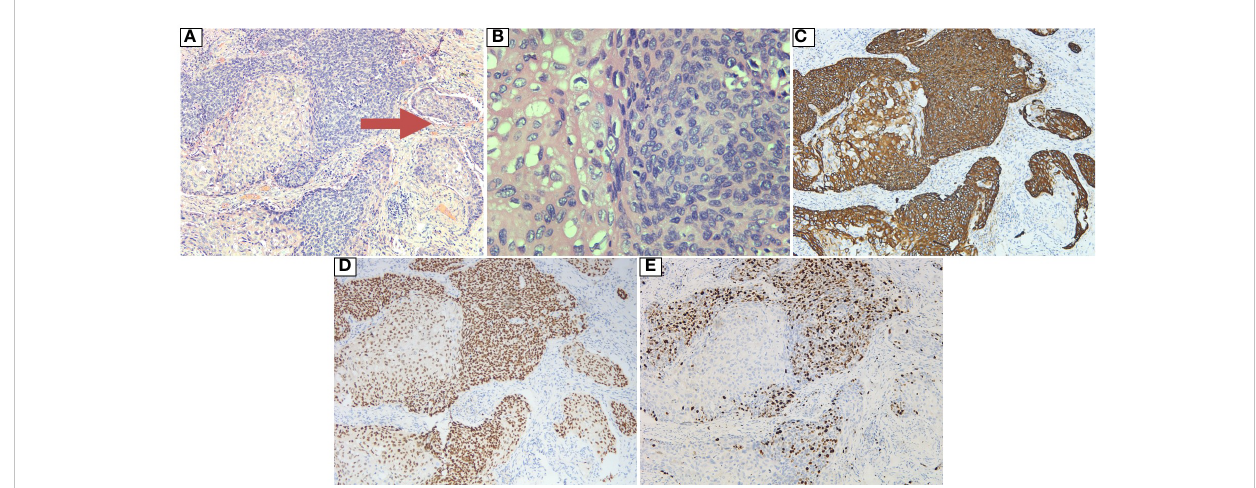
FIGURE 2 Postoperative pathology of the resected esophageal tumor: (A) HE: 10×10. The tumor cells were arranged in a solid nest and grew in an in fi ltrative manner. Intraventricular tumor emboli (indicated by arrow) were observed. (B) HE: 40×10. The tumor cells were polygonal in shape with an eosinophilic cytoplasm, and vacuoles were observed in some of the cytoplasm, with round, oval or irregular nuclei and rough nuclear chromatin; pathological mitosis was observed. (C) Magni fi cation: 10×10. Immunohistochemical marker CK5/6 (+). (D) Magni fi cation: 10×10.